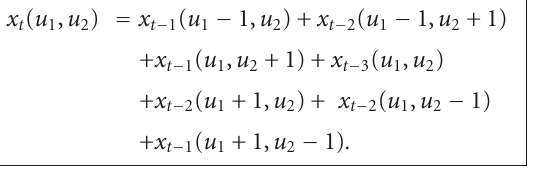
Figure 4: The unicast sessions on the network from Figure 3.